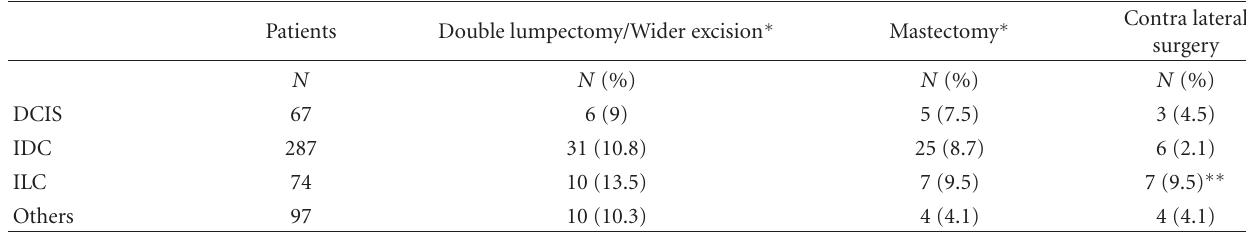
Table 5: Histopatologic type in the subgroups.